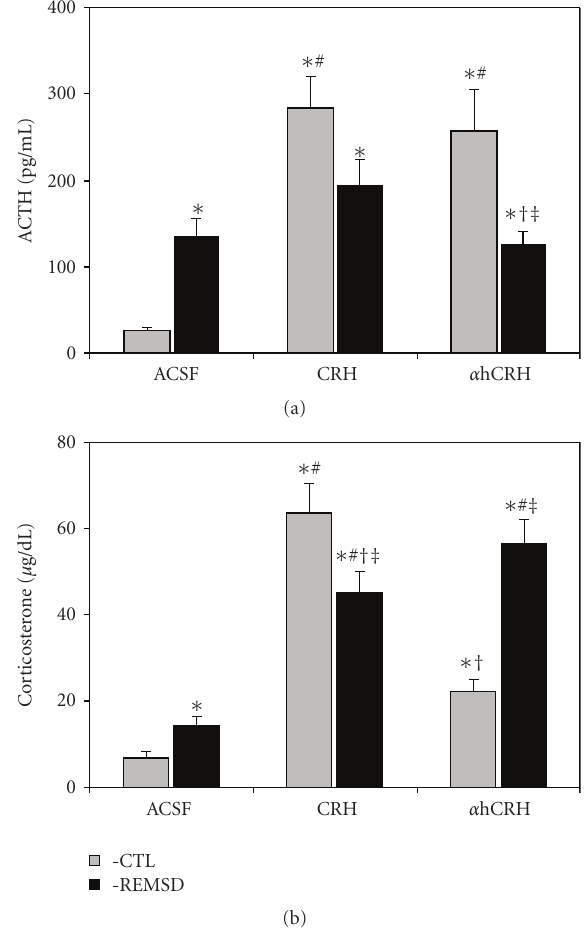
Figure 1: ACTH and CORT Plasma Levels . CTL, Control; ACSF, artificial cerebrospinal fluid; CRH, corticotrophin-releasing hor- mone; α hCRH, alpha-helical CRH 9 − 41 ∗ - di ff erent from CTL+ACSF, # - di ff erent from PSD+ACSF, and † - di ff erent from CTL+CRH, ‡ - di ff erent from CTL+ α hCRH; ANOVA, followed by Newman-Keuls test, P ≤ .